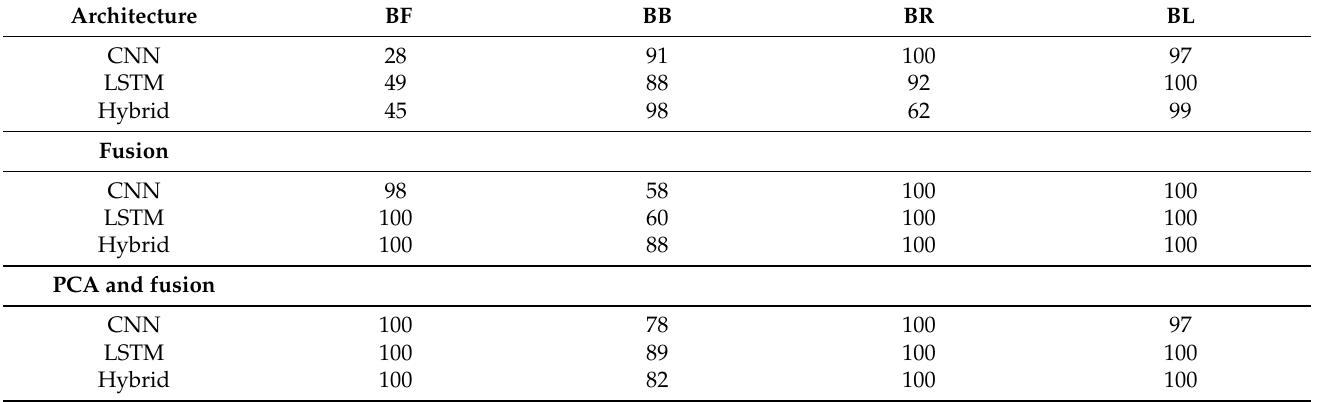
Table 2. The individual data of sensors strip outperform the accelerometer data in the bending-related activities. The data fusion with the accelerometer further strengthens the